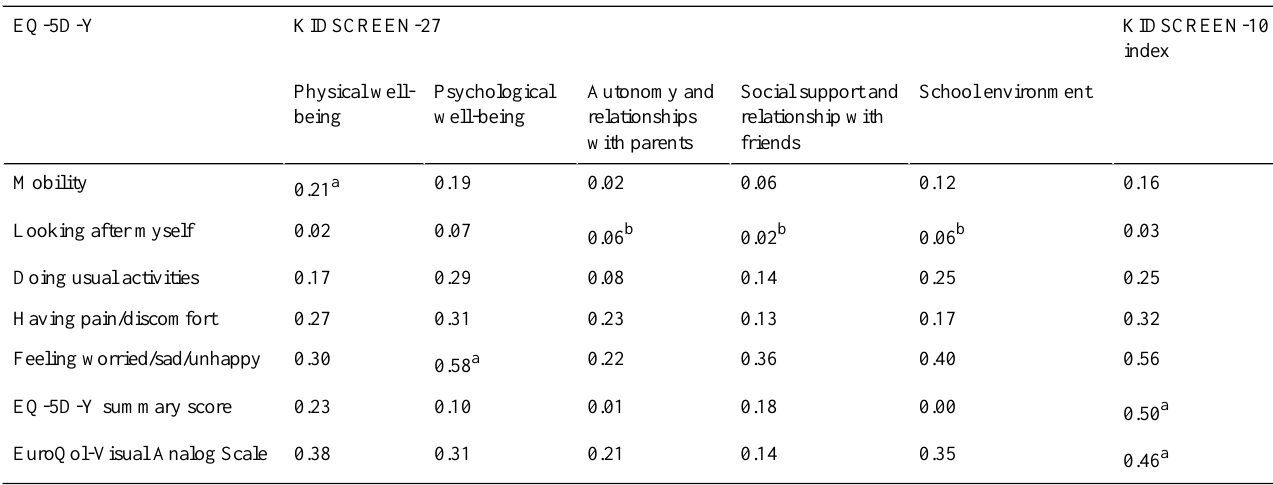
Table 6. Multitrait, multimethod matrix between the EuroQol-5D-Youth (EQ-5D-Y) and the KIDSCREEN in children and adolescents with type 1 diabetes mellitus at baseline evaluation.